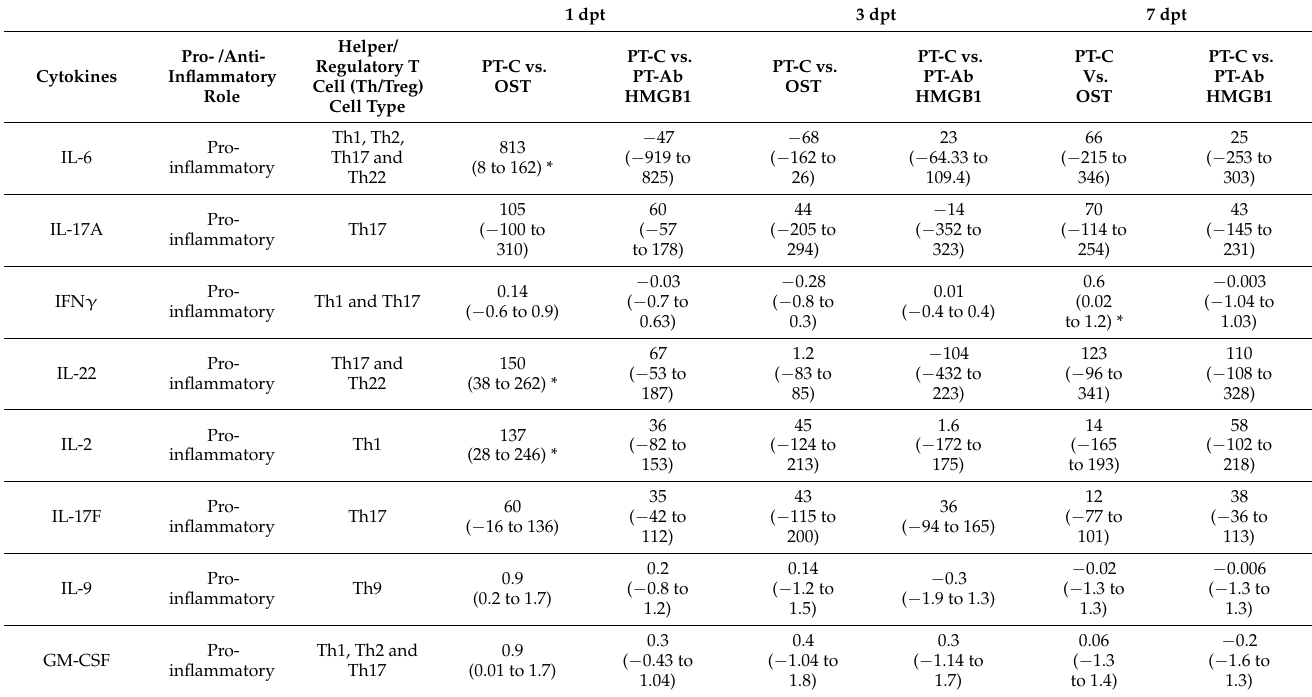
Figure 1. ( A ) Schematic of study design; ( B ) Plasma samples from osteotomy (OST; n = 5), polytrauma (PT-C; n = 5) and polytrauma + anti-HMGB1 antibody (PT-Ab HMGB1; n = 5) at 1, 3 and 7 days post-trauma (dpt) were quantitatively assessed for protein expression of IL-6, IL-17A, IFN γ , IL-13, IL-22, IL-5, IL-2, IL-10, IL17F, IL-9, GM-CSF, IL-4 and TNF α . BD denotes blood draw from the tail vein. * p < 0.05 comparing PT-C to OST. The heat map data are presented as median values. Table 1. Mean difference and 95% confidence interval (CI) of cytokine protein concentrations (pg/mL) in plasma samples from osteotomy (OST; n = 5), polytrauma (PT-C; n = 5) and polytrauma + anti-HMGB1 antibody rats (PT-Ab HMGB1; n = 5) at 1, 3 and 7 days post-trauma (dpt). * p < 0.05 comparing OST and PT-Ab HMGB1 rats to PT-C rats. 1 dpt 3